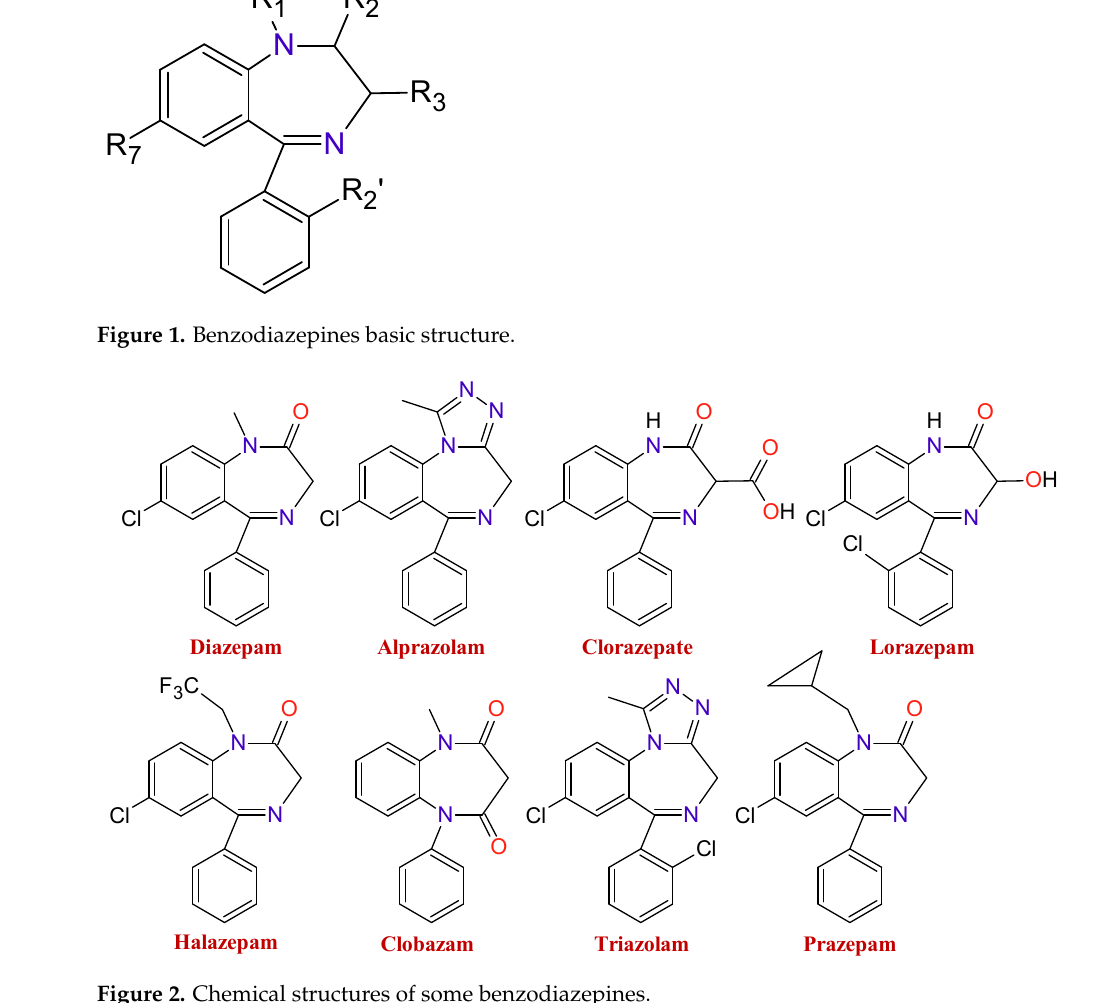
Figure 2. Chemical structures of some benzodiazepines.